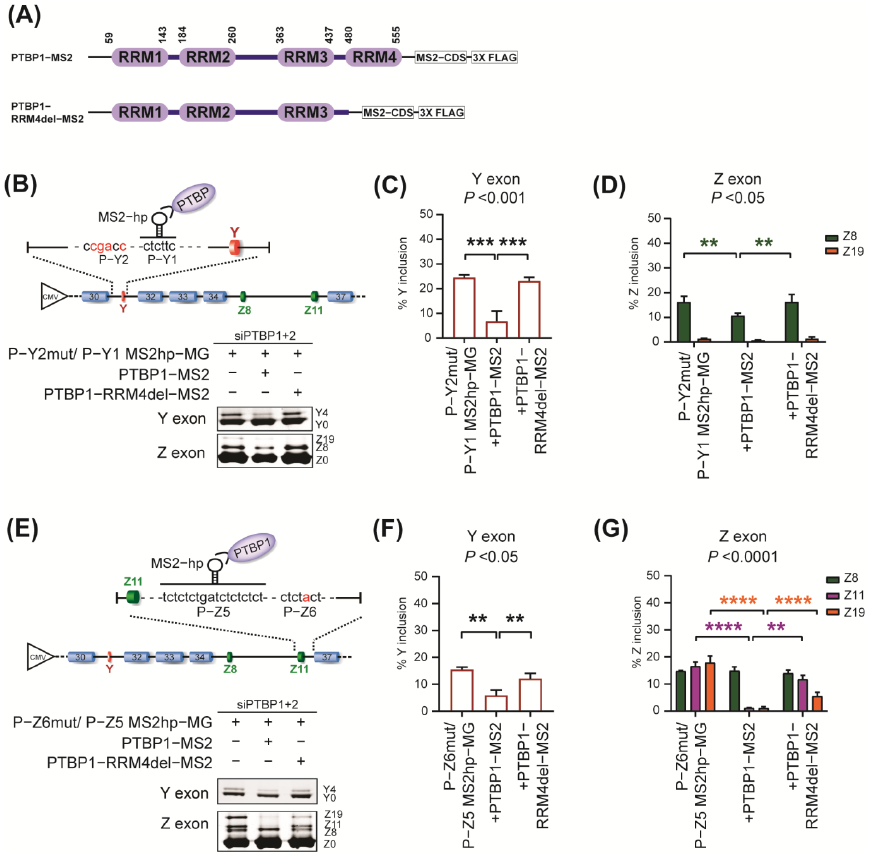
Figure 5. The essential role of RRM4 domain in PTBP1 for the repression of both Y and Z exons. ( A ) Schematic showing full − length PTBP1 (PTBPI − MS2) and RRM4 − deleted PTBP1 (PTBP1 − RRM4del − MS2). Both are fused with MS2 coat protein and 3X FLAG tag. ( B ) The effect of RRM4 deletion on the P − Y1 − mediated splicing repression. PTBP1 − MS2 or PTBP1 − RRM4del − MS2 is tethered to the P − Y1 site in P − Y2mut/P − Y1 MS2hp − MG upon PTBP s knockdown. RT − PCR (below) showing splicing of Y and Z exons. ( C , D ) Quantification of ( B ). ( E ) The effect of RRM4 deletion on the P − Z5 − mediated splicing repression. PTBP1 − MS2 or PTBP1 − RRM4del − MS2 are tethered at the P − Z5 site in P − Z6mut/P − Z5 MS2hp − MG upon PTBP s knockdown. RT − PCR (below) showing splic- ing of Y and Z exons. ( F , G ) Quantification of ( E ). Mean and SD ( n = 3 independent experiments) are indicated in the graphs. P − values of one − way ANOVA ( C,F ) and two − way ANOVA ( D , G ) are indi- cated above the graph. ** p < 0.01, *** p < 0.001, and **** p < 0.0001 using Tukey’s post hoc test when applicable.